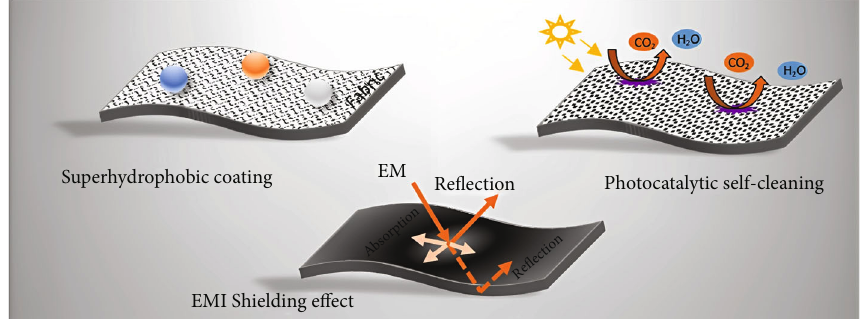
Figure 12: Self-cleaning e ff ect through coatings, photocatalytic, and Electromagnetic interference (EMI) shielding e ff ect [135].